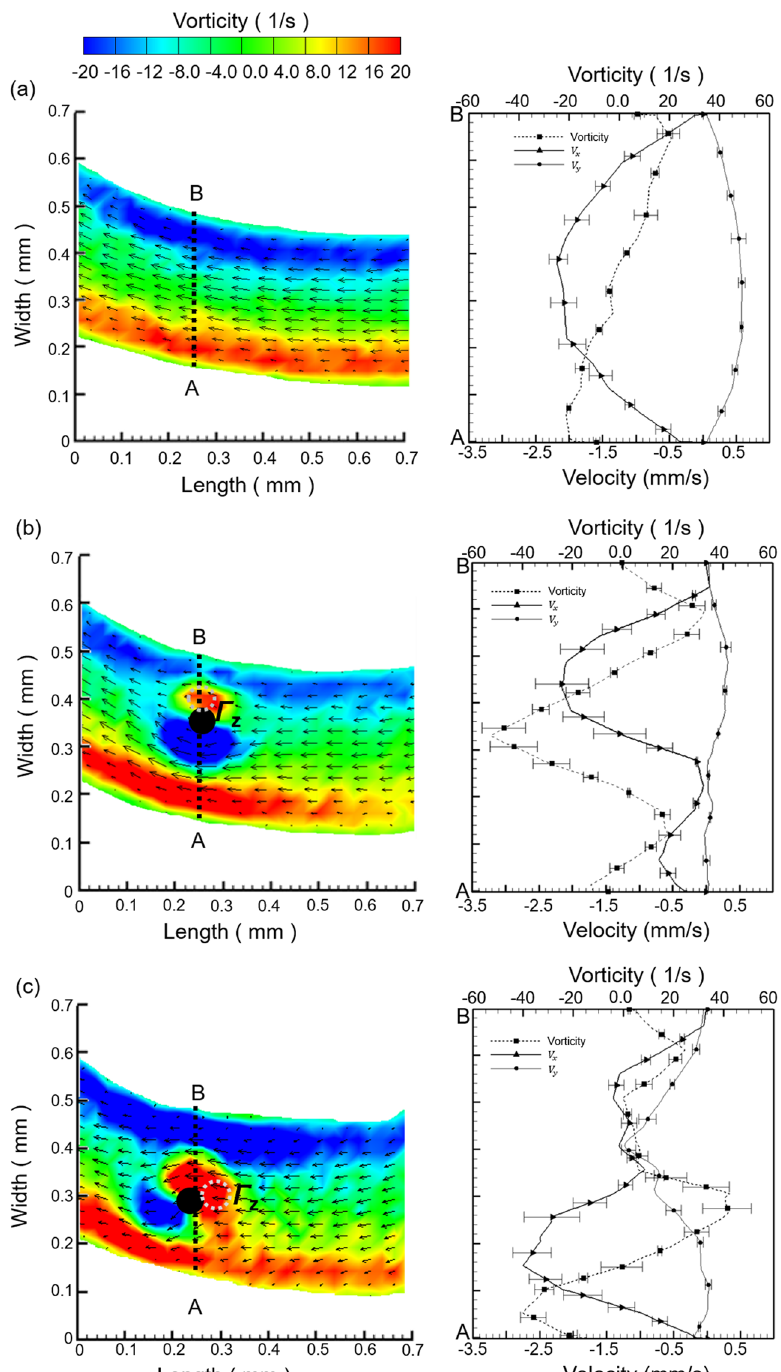
Figure 4. Flow patterns for ( a ) Mode I ( b ) Mode II and ( c ) Mode III in the microchannel. Left column illustrates the time ensemble vorticity contours superimposed with the ensemble average velocity. Right column illustrates the quantified vorticity and velocity along the AB line. Black circle represents the artificial